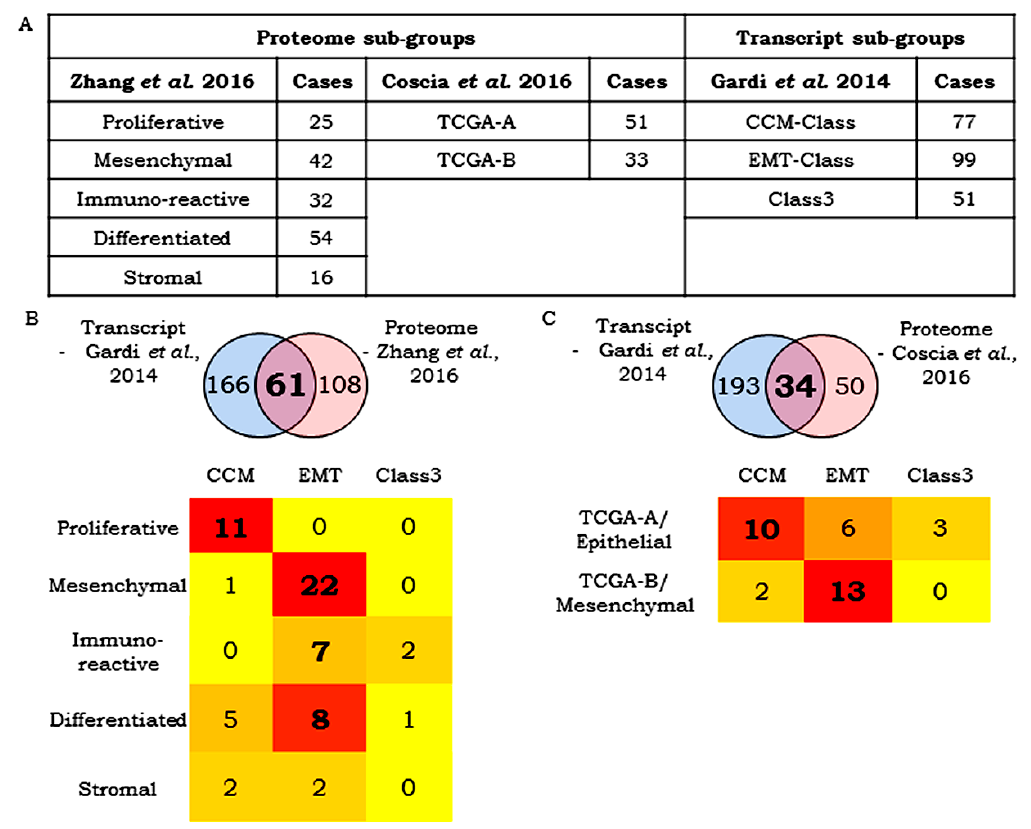
Figure 6. Comparison of HGSC stratification approaches. ( A ) Proteomics-based TCGA HGSC tumors stratification in 5 sub-groups by Zhang et al. 2016 (169 cases) and Coscia et al. 2016 (84 cases) and transcriptomics based HGSC stratification into three classes (Gardi et al. 2014); ( B ) comparison of Gardi et al. 2014 vs. Zhang et al., 2016; ( C ) comparison of Gardi et al. 2014 vs. Coscia et al. 2016.